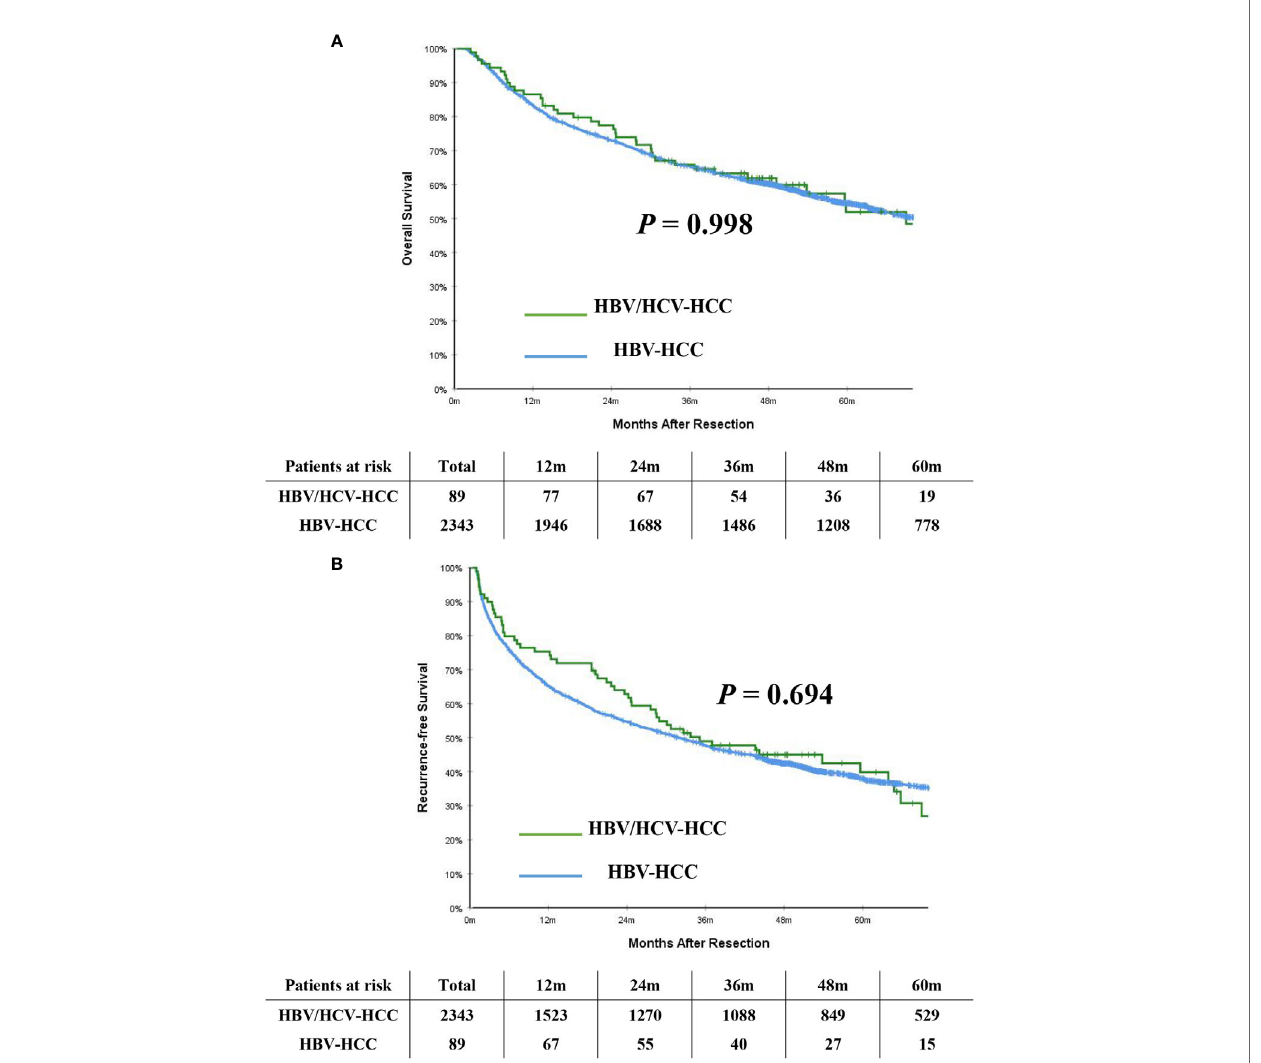
FIGURE 2 | Kaplan-Meier curves of overall survival (A) and recurrence-free survival (B) between patients with HBV/HCV-HCC and HBV-HCC in the entire